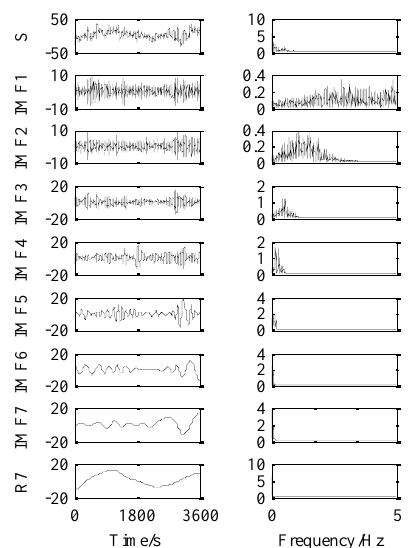
Figure 11. Decomposition result of the noisy observation sequence in the horizontal direction using EMD.